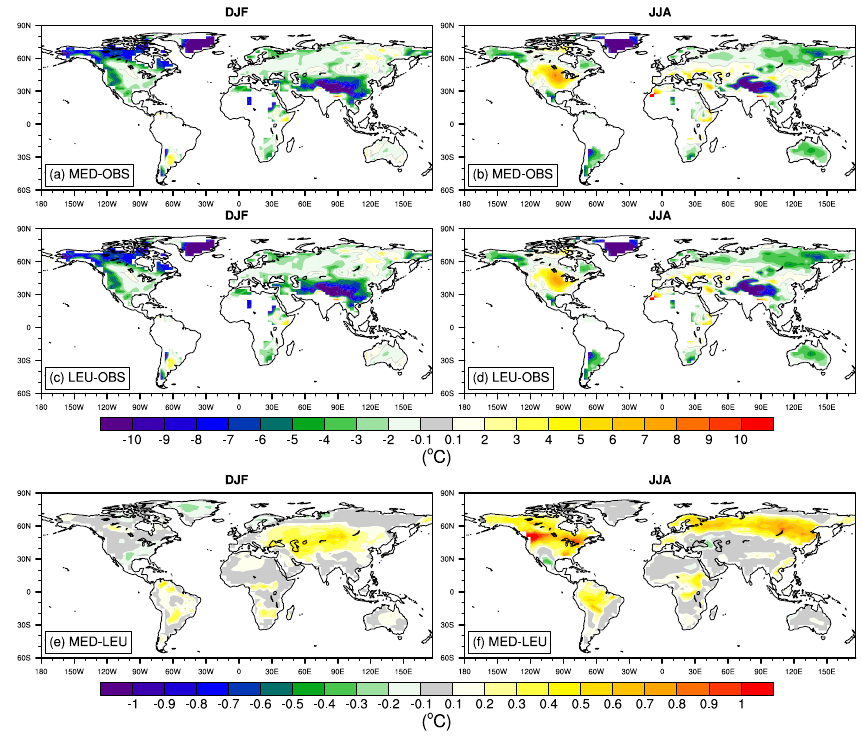
Figure 2. (a – d) : mean seasonal difference in maximum temperature ( T MAX ) between the MED and LEU experiments and the HadGHCND data set (OBS) during boreal summer (JJA, left panels) and winter (DJF, right panels). (e – f) : difference between the MED and LEU simula- tions. Seasonal means are computed over the period 1960–2010. Inland areas in white for panels (a – d) represent missing